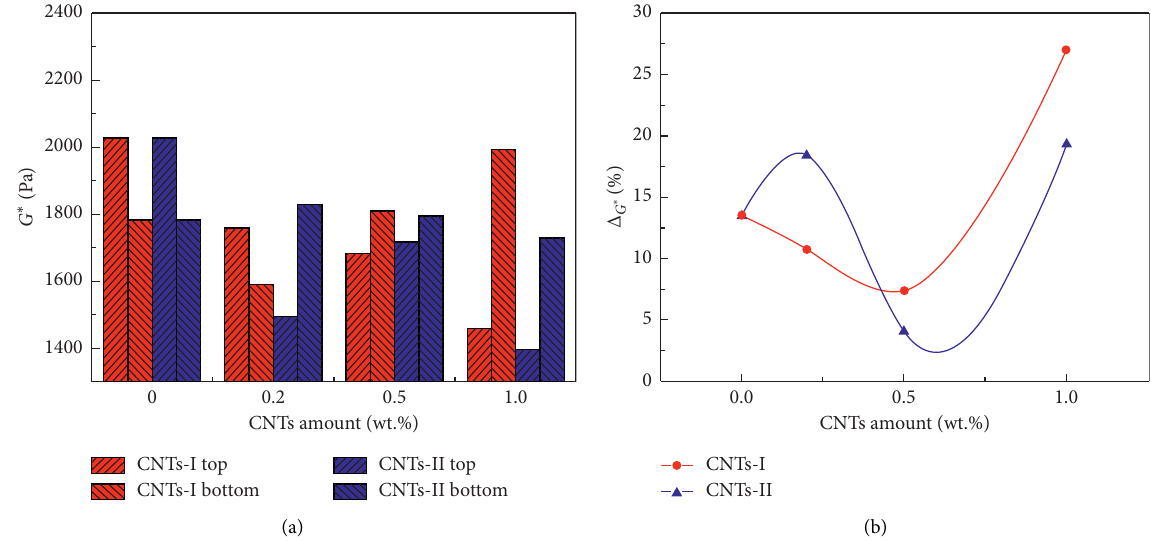
Figure 7: Changes in complex modulus ( G ∗ ) and separation degree ( △ G ∗ ) with different CNTs amounts. (a) G ∗ changes with CNTs amounts. (b) △ G ∗ changes with CNTs amounts.